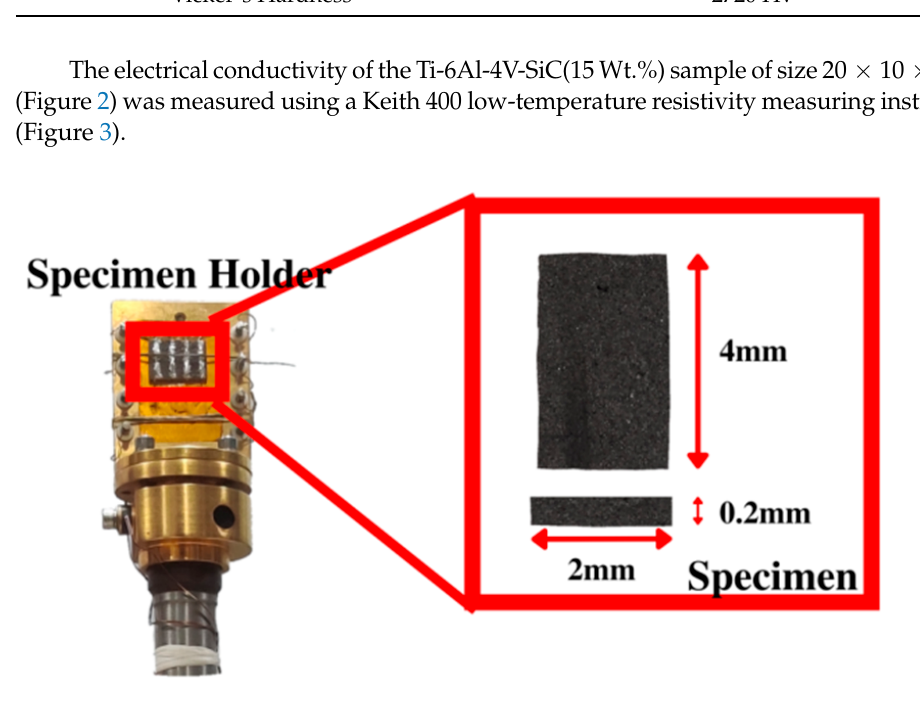
Figure 2. Workpiece for measuring electrical conductivity.